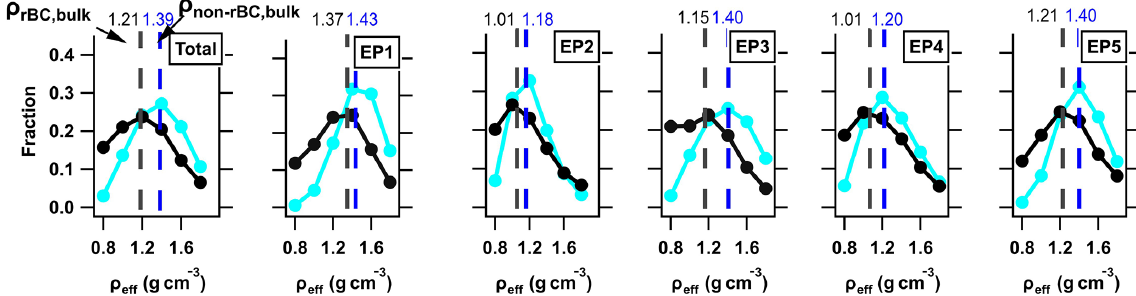
Figure 5. Number distributions of rBC-containing particles (black lines) and non-rBC particles (blue lines) with different effective densities during different episodes. The black dashed line denotes the effective density of bulk rBC-containing particles, and the blue dashed line denotes the effective density of bulk non-rBC particles.